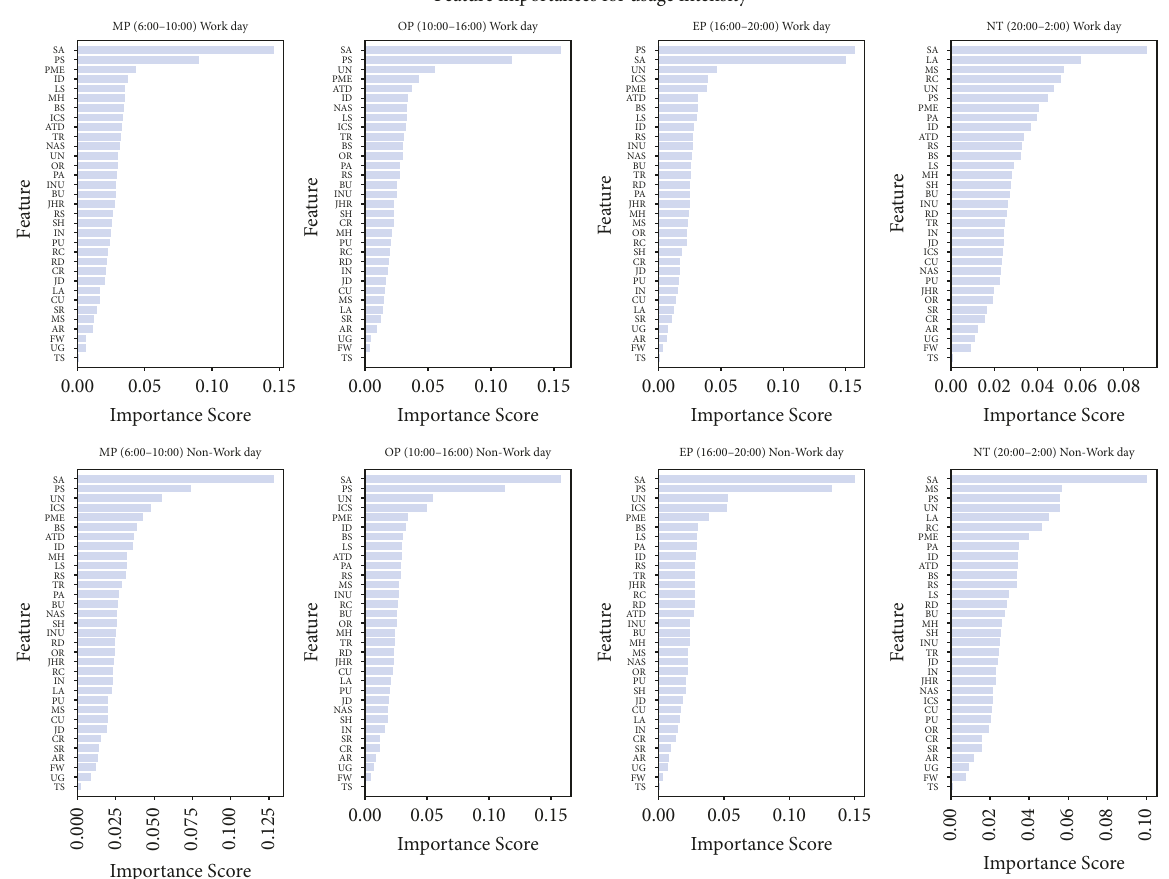
Figure 4: Feature importance for usage